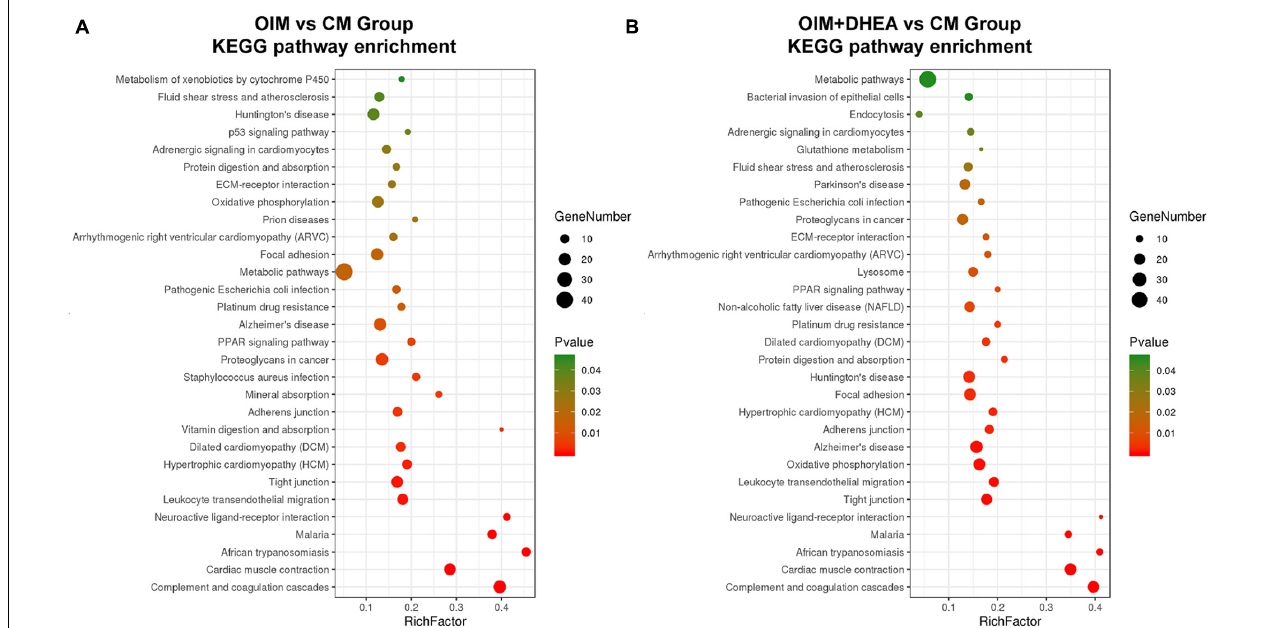
FIGURE 5 | The enriched KEGG pathways of differentially expressed proteins (DEGs). The top 30 enriched KEGG pathways of the DEPs in OIM vs. CM (A) and OIM+DHEA vs. CM (B) . Cut-off value: p -value < 0.05.